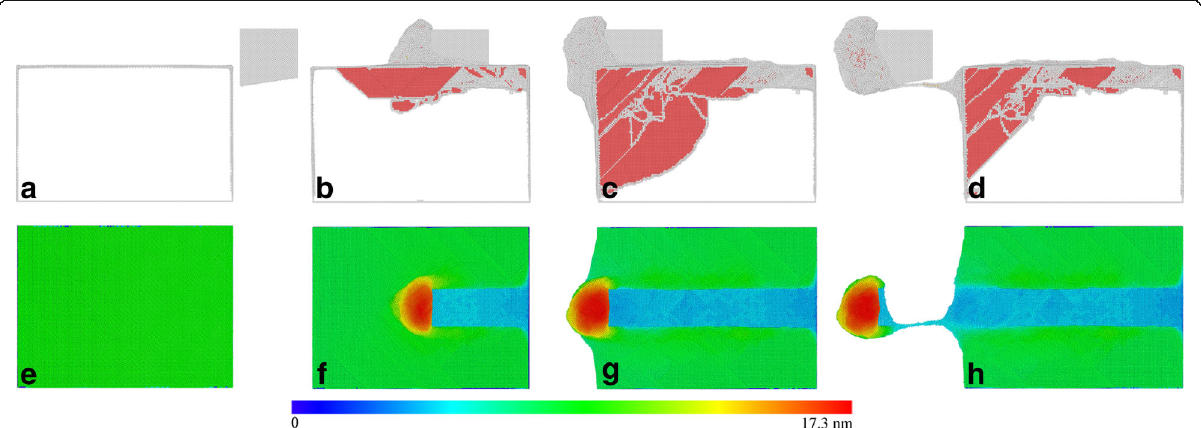
Fig. 4 Defect structures and machined surface morphologies; (color online) MD snapshots of instantaneous defect structures ( top row ) and machined surface morphology ( bottom row ) in the diamond cutting of Ce(010) under a rake angle of 0°. Cutting lengths: a , e 0.0 nm, b , f 18.8 nm, c , g 44.8 nm, and d , h 59.6 nm. Atoms in the top row and bottom row are colored according to their CNA values and atomic heights, respectively